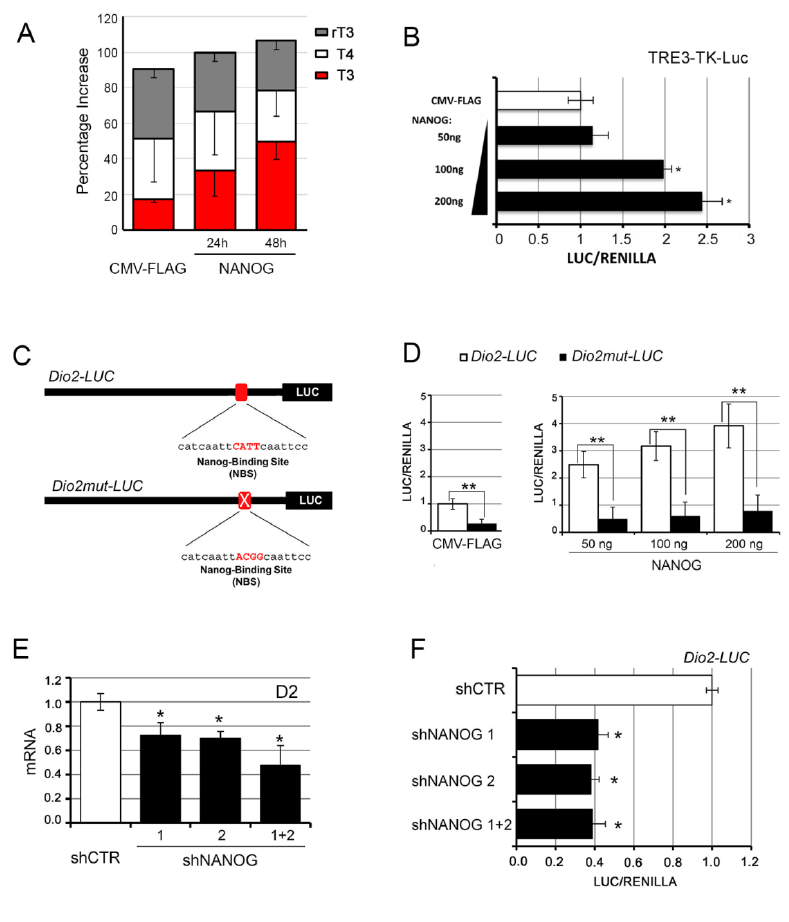
Figure 2. NANOG downregulation reduces the expression of D2 in BCC cells. ( A ) Levels of T3, T4, and rT3 measured by HPLC–MS in the culture medium of BCC cells transiently transfected with NANOG. Values are expressed as percentage of total thyroid hormones (THs). ( B ) BCC cells were transiently transfected with the TRE3-TK-LUC promoter and with increasing amounts of the NANOG plasmid. Cells were harvested 48 h after transfection and analyzed for luciferase activity. CMV-Renilla was co-transfected as an internal control. The results are shown as means ± SD of the LUC / Renilla ratio from at least three separate experiments, performed in triplicate; * p < 0.05, ** p < 0.01. ( C ) Schematic representation of the NANOG binding site mutation within the Dio2 promoter region. ( D ) BCC cells were transiently transfected with Dio2-LUC promoter or Dio2mut-LUC promoter and CMV-FLAG (left) or increasing amounts of NANOG plasmid (right). Cells were harvested 48 h after transfection and analyzed for luciferase activity. CMV-Renilla was co-transfected as an internal control. The results are shown as means ± SD of the LUC / Renilla ratio from at least three separate experiments, performed in triplicate; * p < 0.05, ** p < 0.01. ( E ) D2 mRNA expression was measured by real-time PCR in BCC cells transfected with two di ff erent NANOG shRNAs, as single plasmids or in combination, or a control (CTR) shRNA as indicated. ( F ) BCC cells were transiently transfected with Dio2-LUC promoter and with NANOG shRNA as in E. Cells were harvested 48 h after transfection and analyzed for luciferase activity. CMV-Renilla was co-transfected as an internal control. The results are shown as means ± SD of the LUC / Renilla ratio from at least three separate experiments, performed in triplicate; * p < 0.05, ** p <